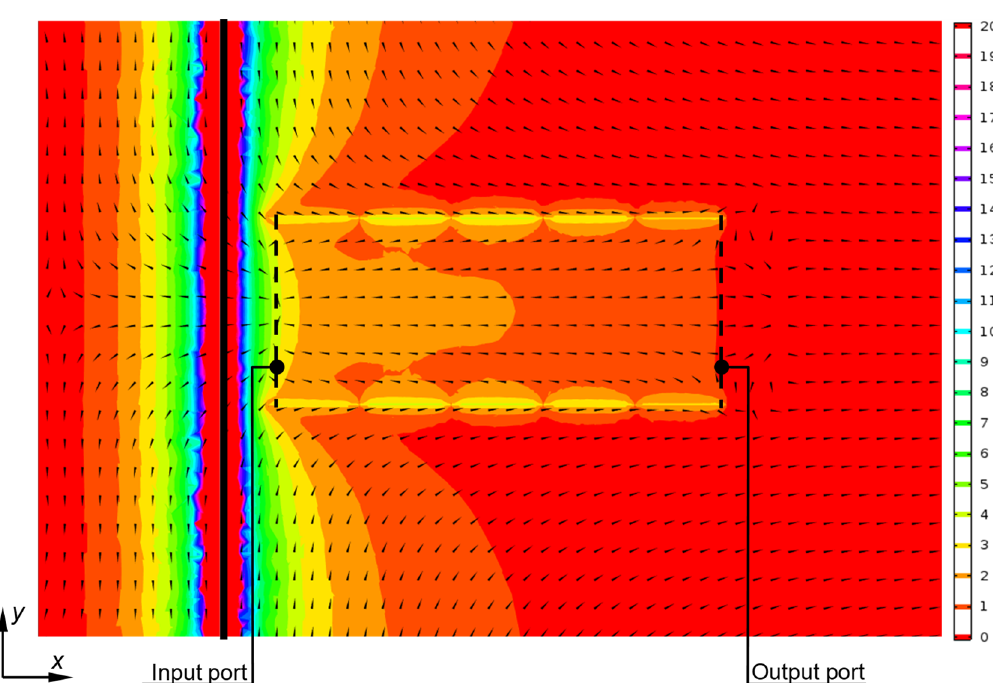
Figure 8. Magnetic field norm (color) and normalized power flow (black arrows) for the best model with the magnetic meta-hose ( ν = 0.15, µ m = 150) at f r = 25 kHz.